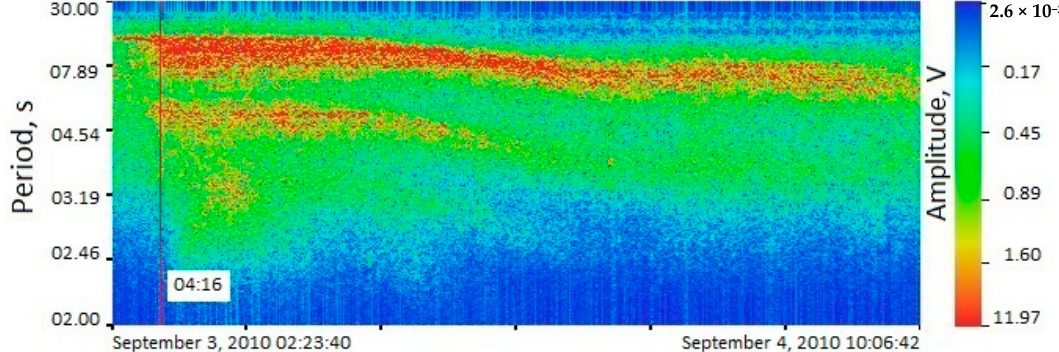
Figure 6. Time of swell waves arrival to the registration point.